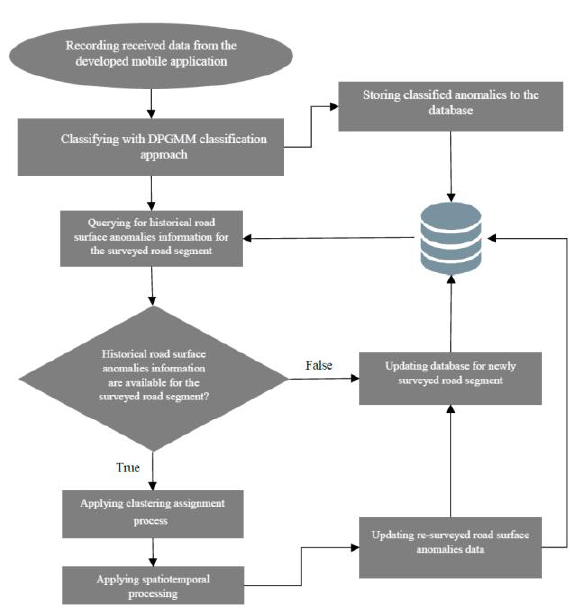
Figure 1. The proposed spatiotemporal crowdsourcing